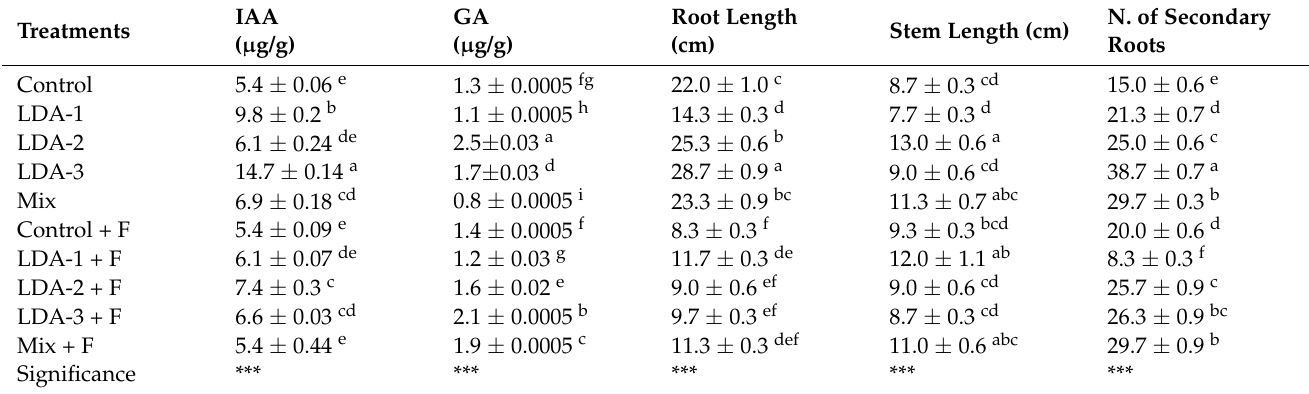
Table 4. Effect of B. subtilis strains (LDA-1, LDA-2, and LDA-3) on physiological parameters